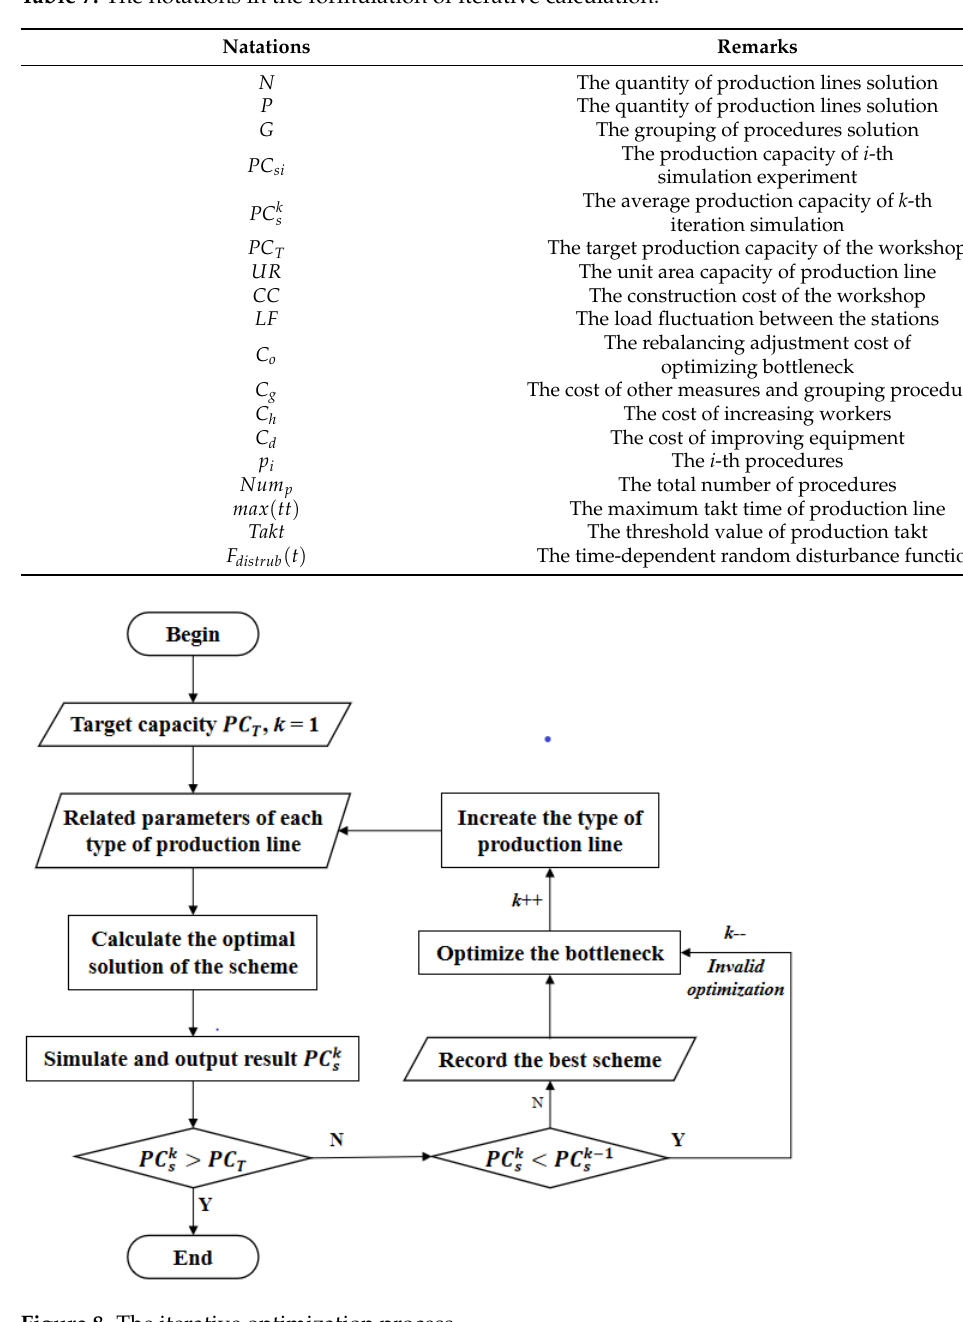
Figure 8. The iterative optimization